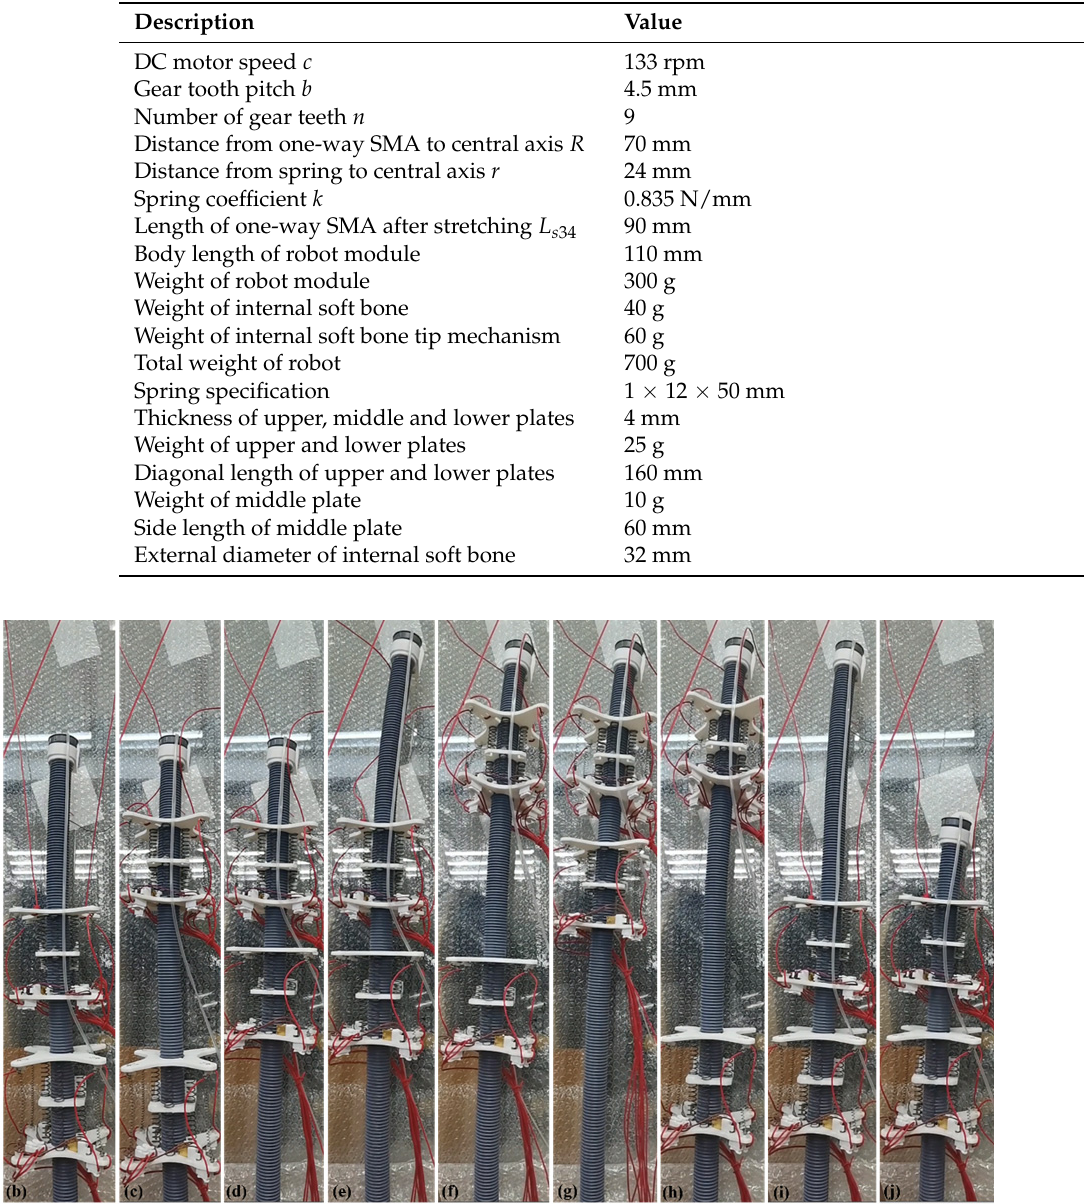
Table 2. ISB-MWCR mechanical structure parameter table.